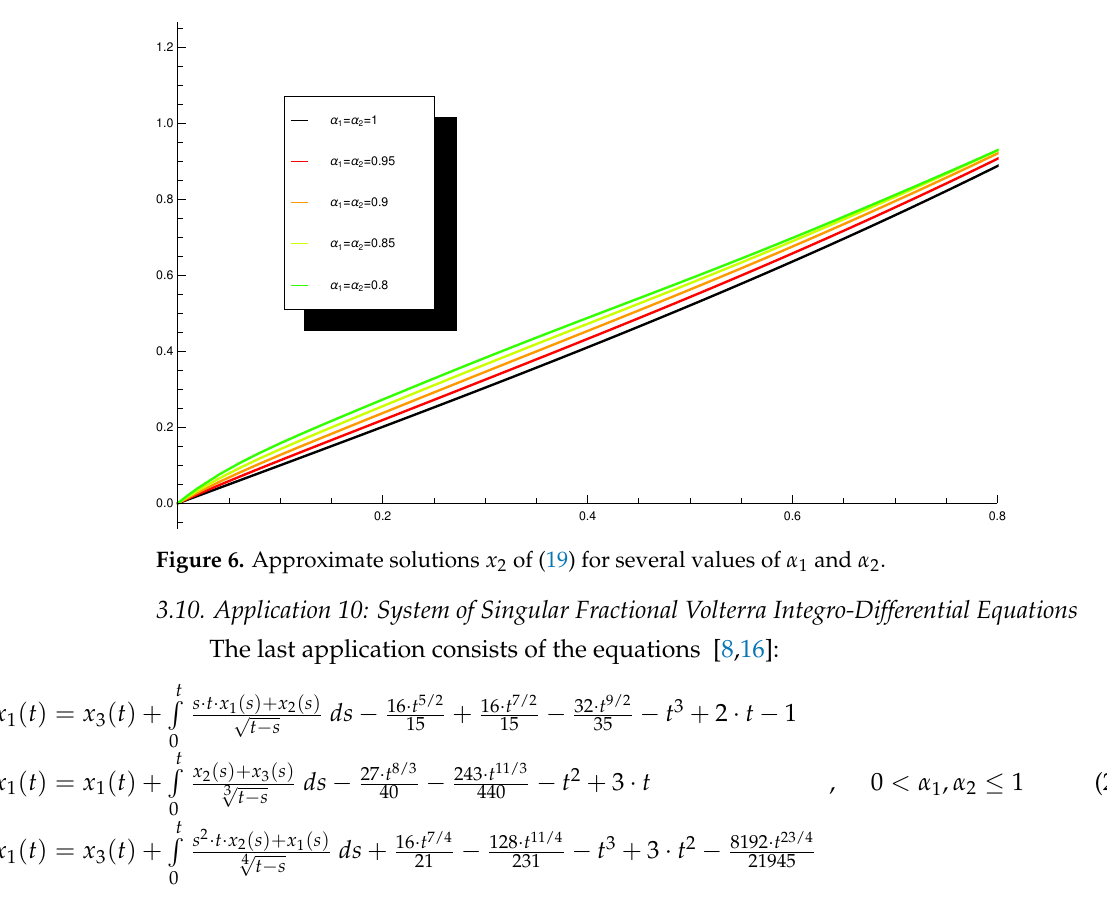
Figure 5. Approximate solutions x 1 of (19) for several values of α 1 and α 2 .